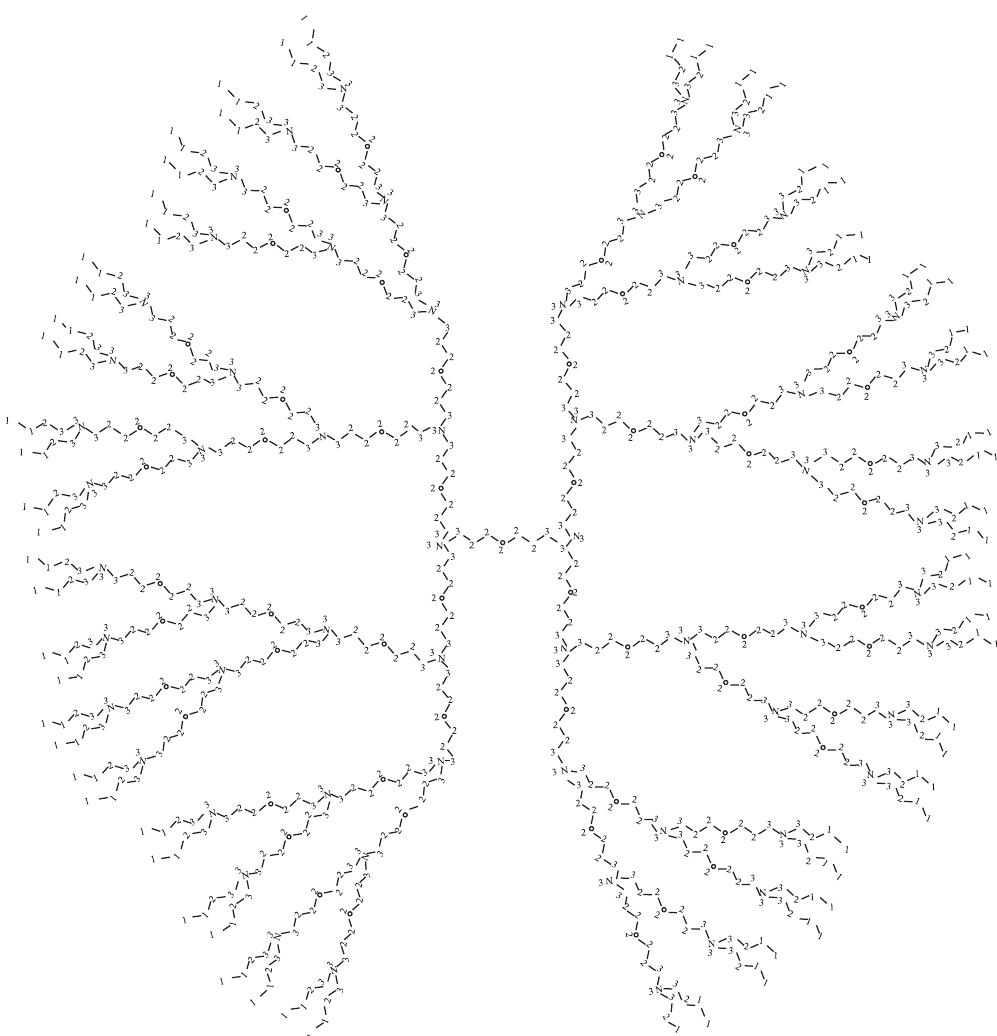
Figure 2: Structural formula of PPEI dendrimer for t � 5 along with